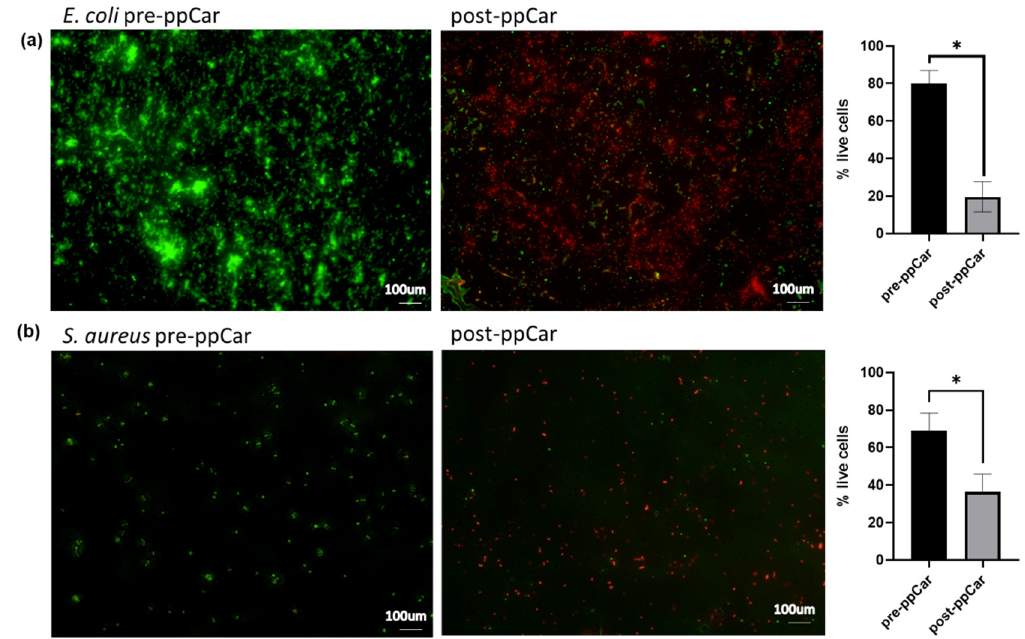
Figure 8. Live/dead bacterial assay of ( a ) E. coli and ( b ) S. aureus before and after ppCar on glass slides. Green represents live bacterial cells; red represents dead cells. * p ≤ 0.05 indicates significant differences in the fabricated materials.